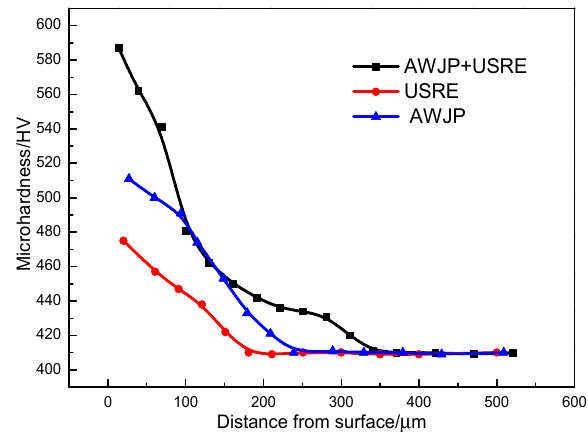
Figure 12. Comparison of microhardness along the thickness direction.